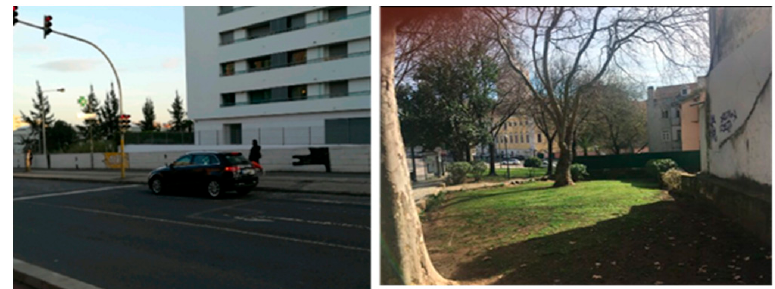
also containing illegal graffiti (( central ) and ( right ) images).